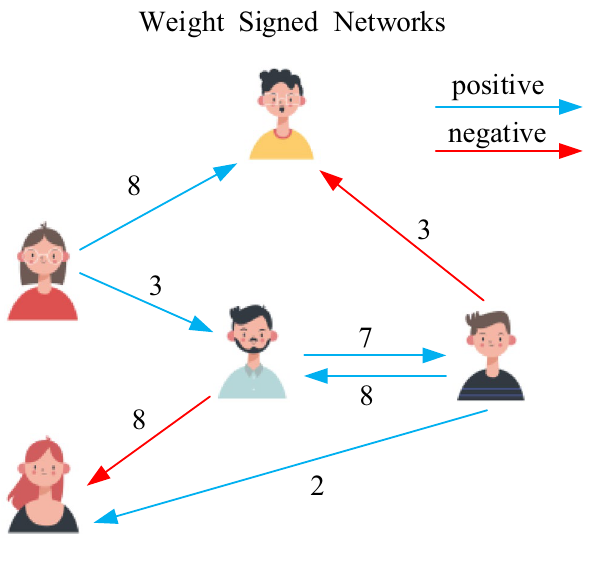
Fig. 1 Weight signed